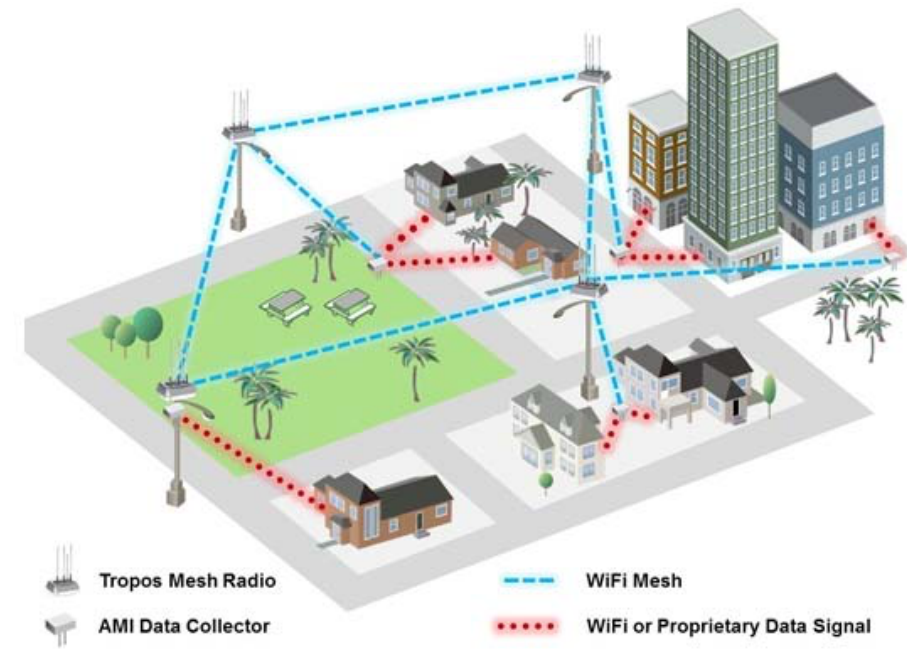
Figure 1. Diagram of smart grid.